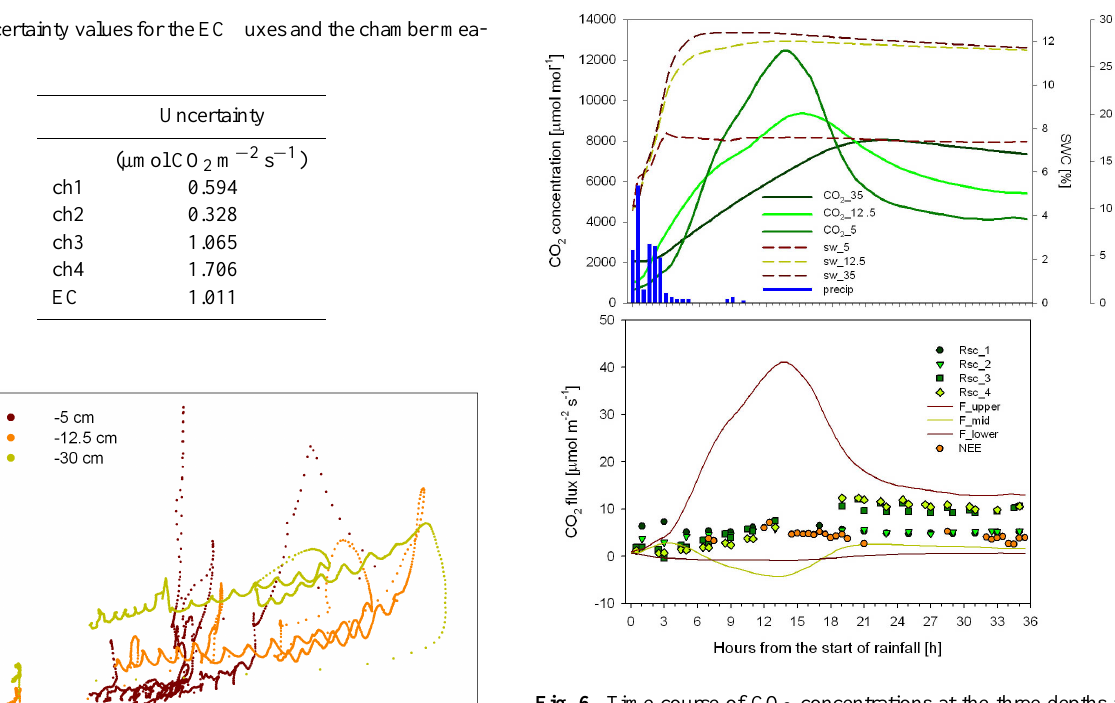
Fig. 6. Time course of CO 2 concentrations at the three depths af- ter a rain event (on the 4 August, also shown in Fig. 9). F_upper: CO 2 flux between 5cm depth and the surface, F_mid: CO 2 flux between 12cm and 5cm depths, F_lower: CO 2 flux between 35cm and 12cm depths, respectively. Rsc_1, Rsc_2, Rsc_3, Rsc_4 and NEE are the fluxes measured by the chambers and EC system, re-